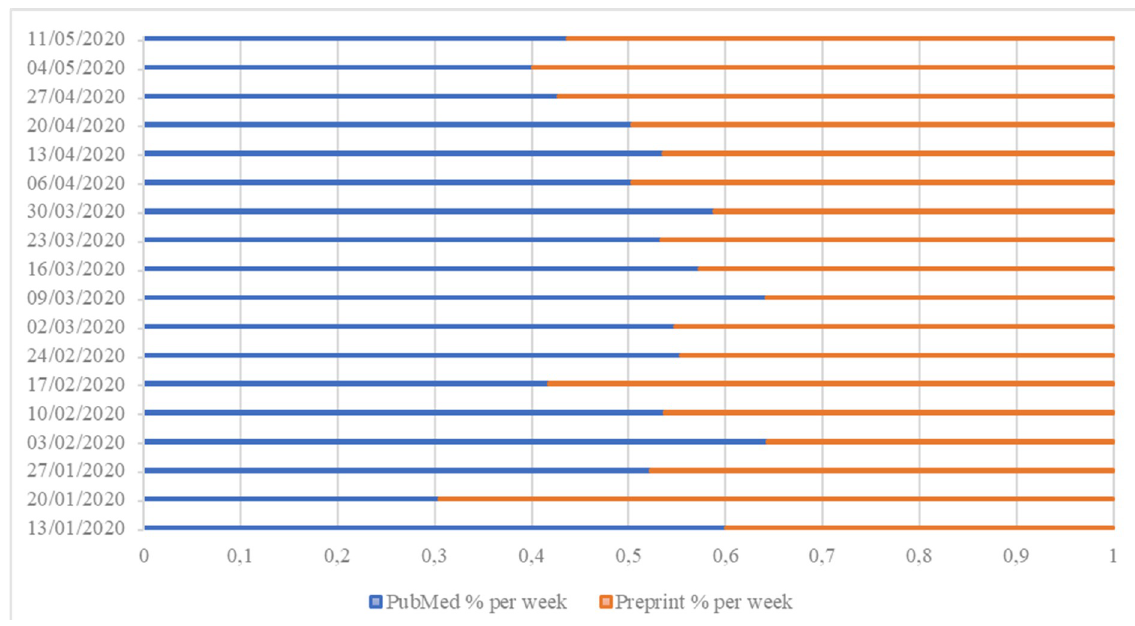
Fig 3. Relative distribution of academic and preprint publications by week.